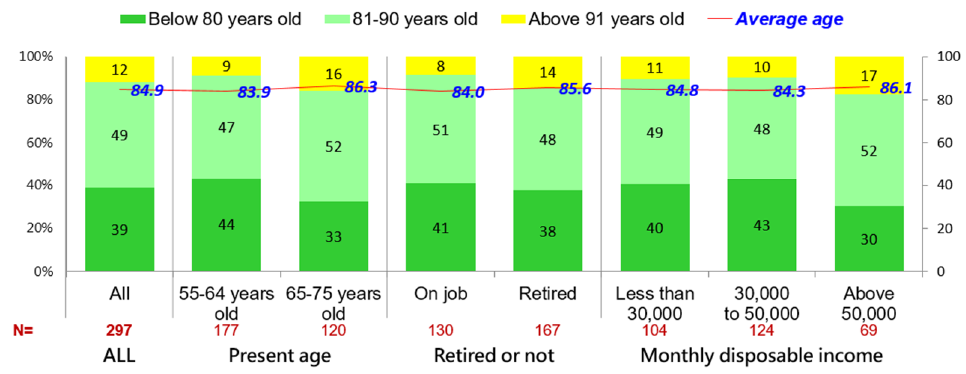
Figure 2. Self-age prediction of those aged 55–75 years.